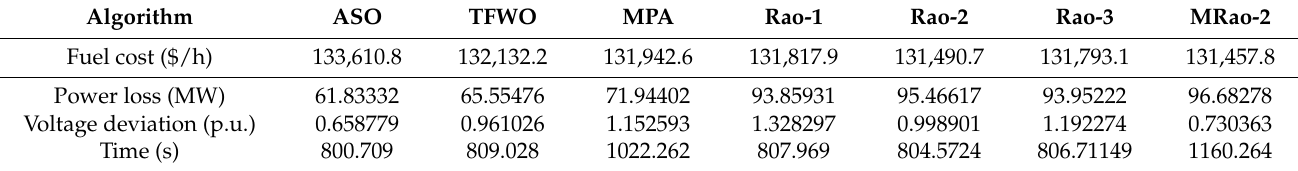
Table 10. Results of the proposed MRao-2 algorithm and other algorithms for case